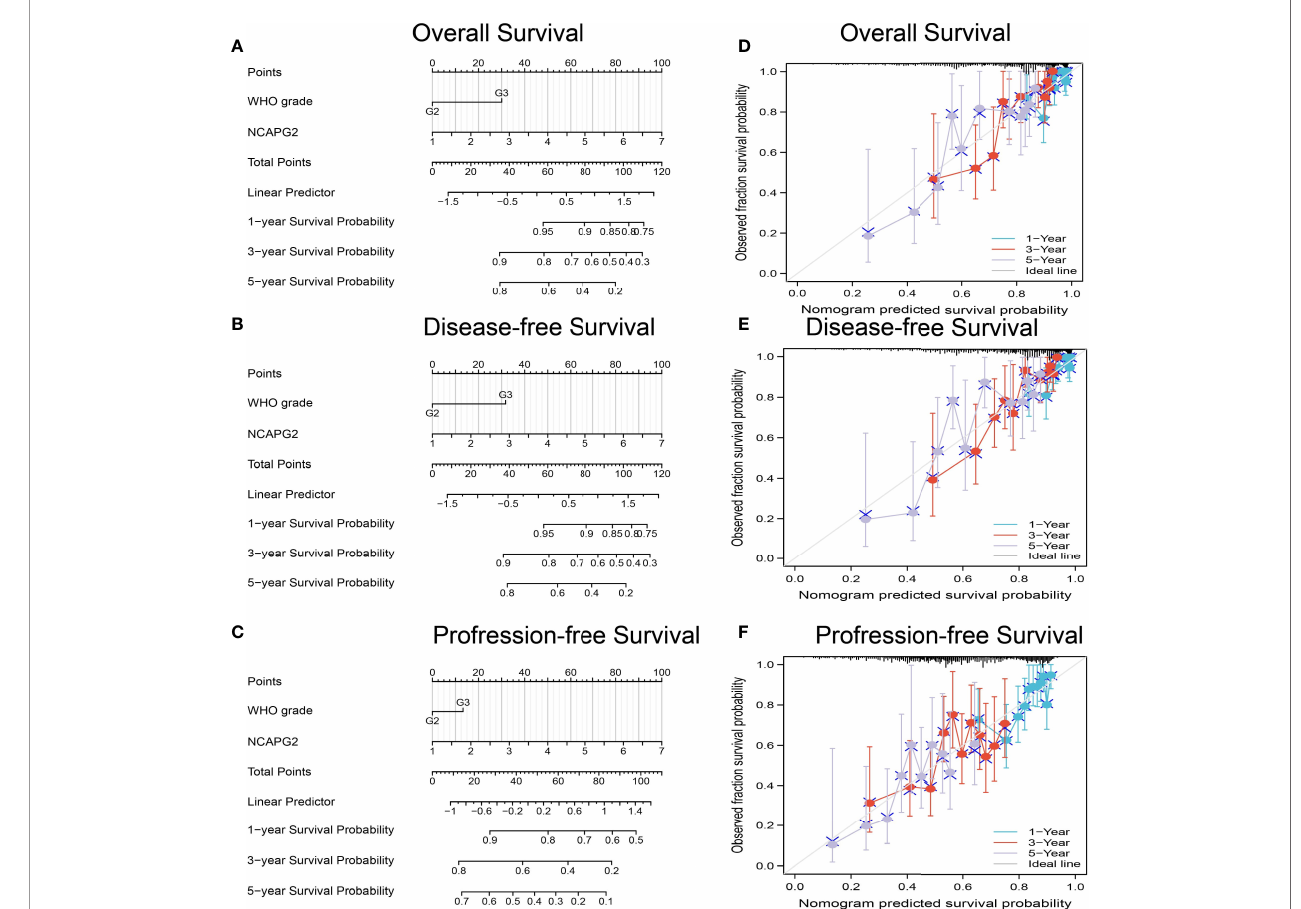
FIGURE 6 | Construction a nomogram to predicted the prognosis of NCAPG2 in LGG. Construction a nomogram to predicted the (A) OS, (B) DSS, and (C) PFI in LGG patients. The calibration curve used to display the TCGA-LGG cohort for (D) OS, (E) DSS and (F)